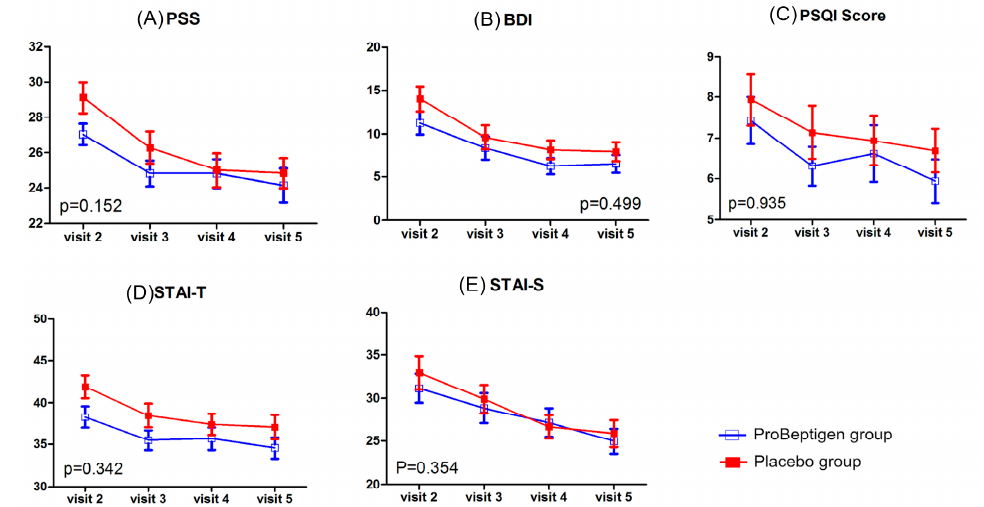
Figure 5. Results of perceived stress, depression, anxiety and sleep quality measurements. ( A ) Perceived Stress Score (PSS), ( B ) Beck Depression Inventory-II (BDI), ( C ) Pittsburg Sleep Quality Index (PSQI), ( D ) State-Trait Anxiety Inventory–trait anxiety (STAI-T), ( E ) STAI-S, State-Trait Anxiety Inventory–state anxiety (STAI-S). Error bars represent standard errors. The p -value shown in each diagram denotes the statistics of time × treatment interaction after considering the baseline data as a covariate. Lower scores indicate fewer symptoms.